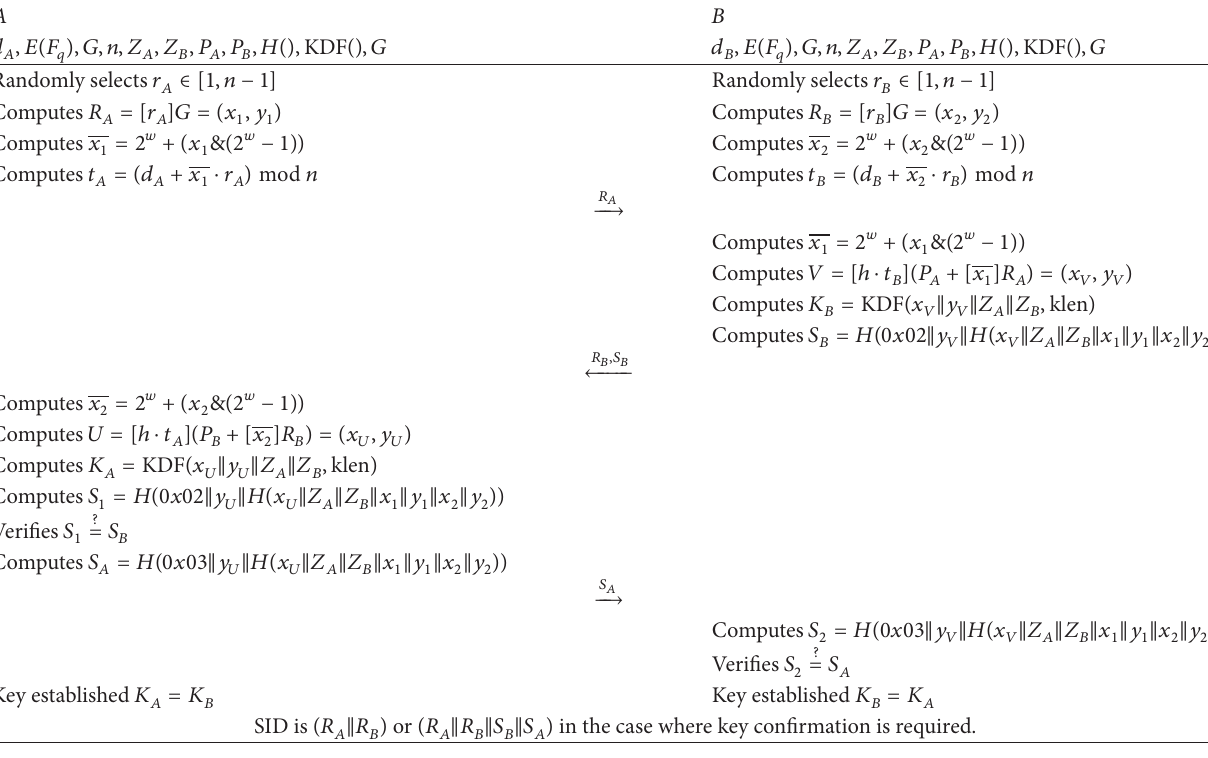
Table 1: SM2 key exchange